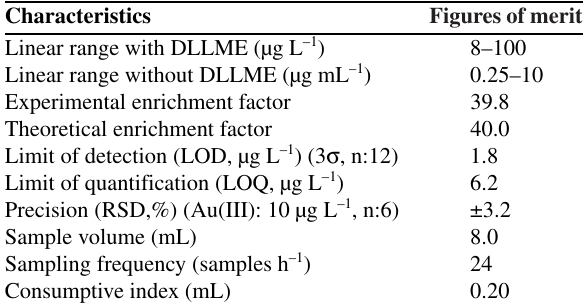
Table 5. Tolerable concentration of the interfering ions on the de- termination of 50 μg L –1 Au(III) ions using IP-DLLME (n =